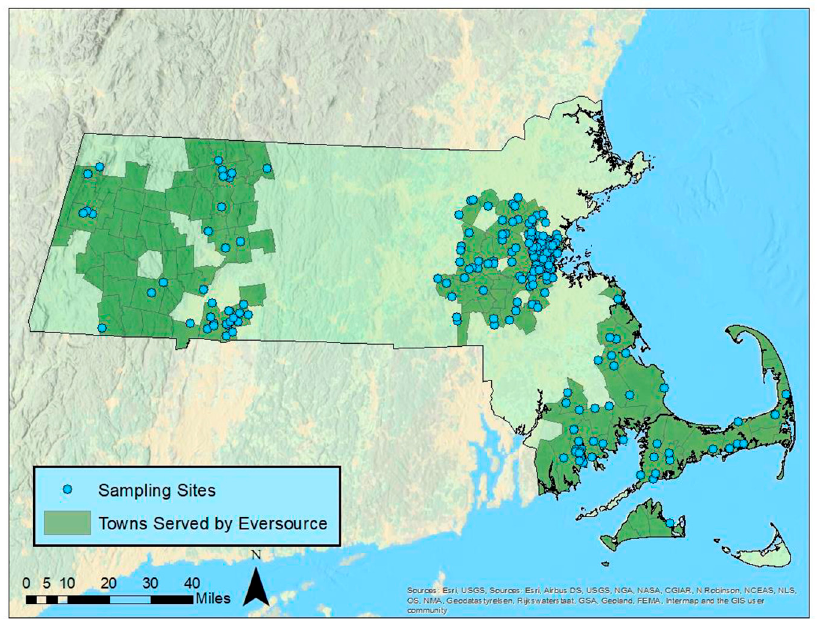
Figure 1. Distribution of sampling sites throughout Eversource Energy’s service areas in Massachusetts, USA.